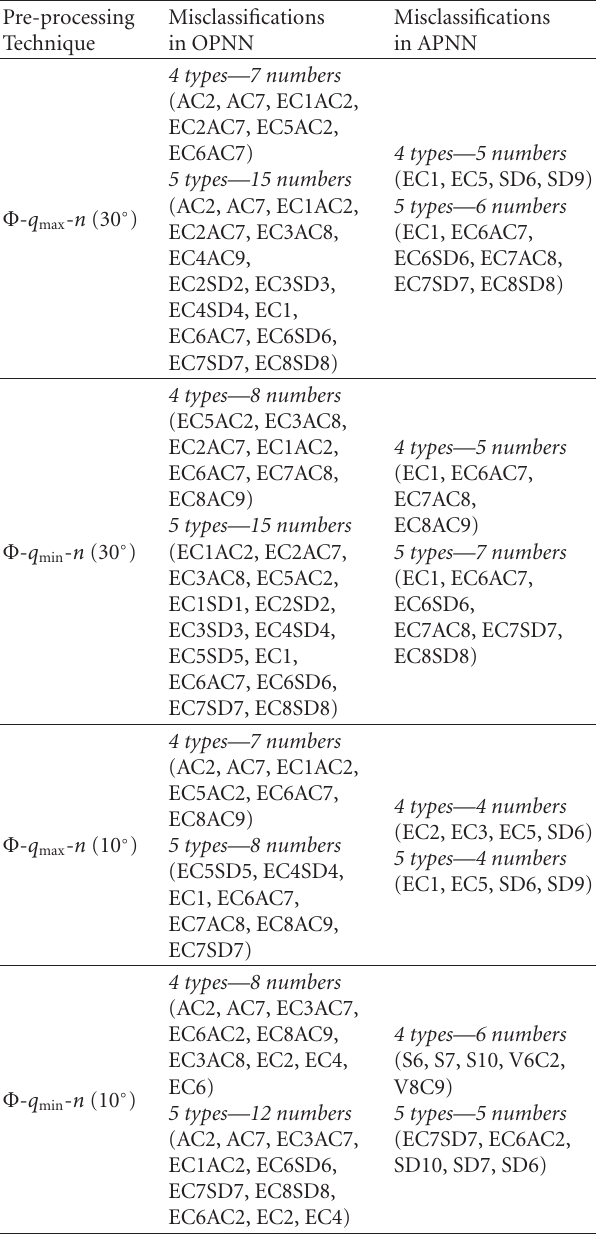
Table 3: Classification capability of PNN and APNN for moderate database—without clustering